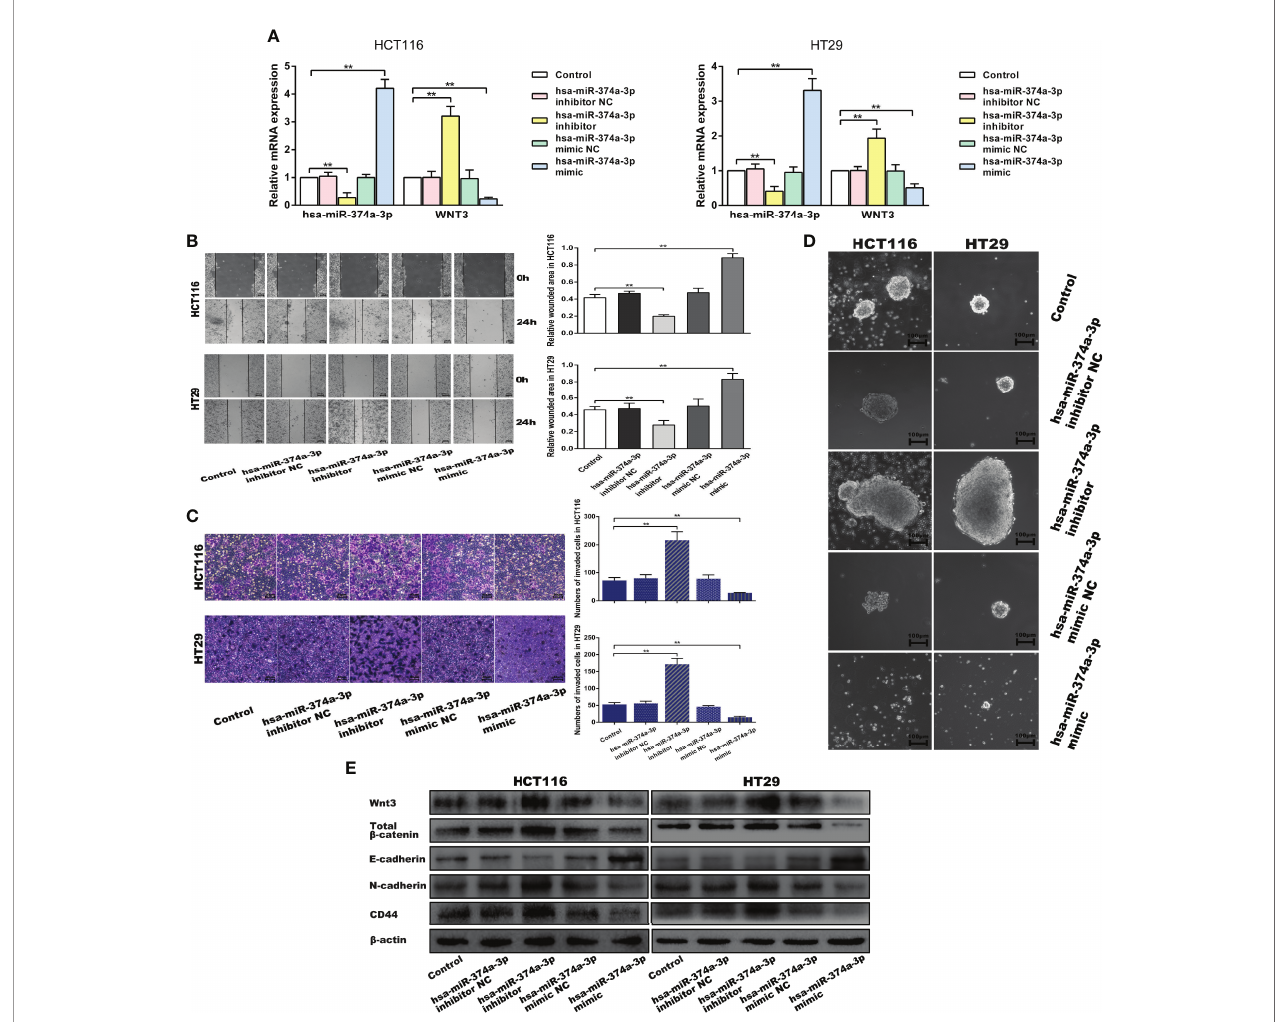
FIGURE 4 | Hsa-miR-374a-3p plays an inhibitive role in the motility and cellular plasticity of COAD cells by suppressing WNT3/ b -catenin signaling. (A) mRNA expression of hsa-miR-374a-3p and WNT3 was detected by PT-PCR assay. (B) Wound-healing assay was performed to assess the migration ability of CAOD cells. (C) Transwell assay was used to evaluate the invasion ability. (D) Spheroid formation assay proceeded to estimate the cellular plasticity. (E) Protein levels of WNT3/ b -catenin, EMT, and cellular plasticity-related molecules were tested by Western blot experiment. *P < 0.05, **P < 0.01 compared to control